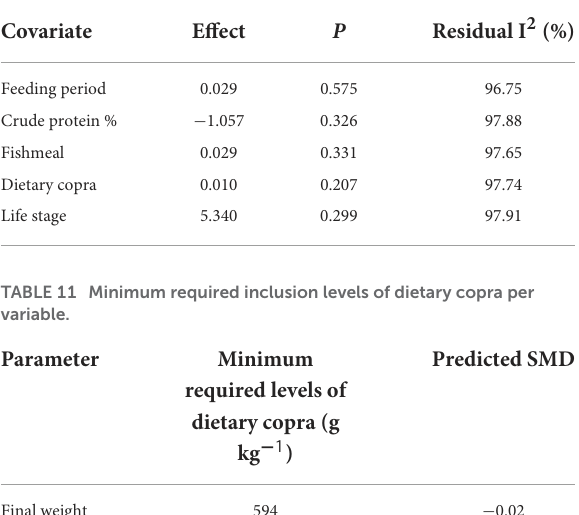
TABLE 10 Meta-regression for lipid composition.